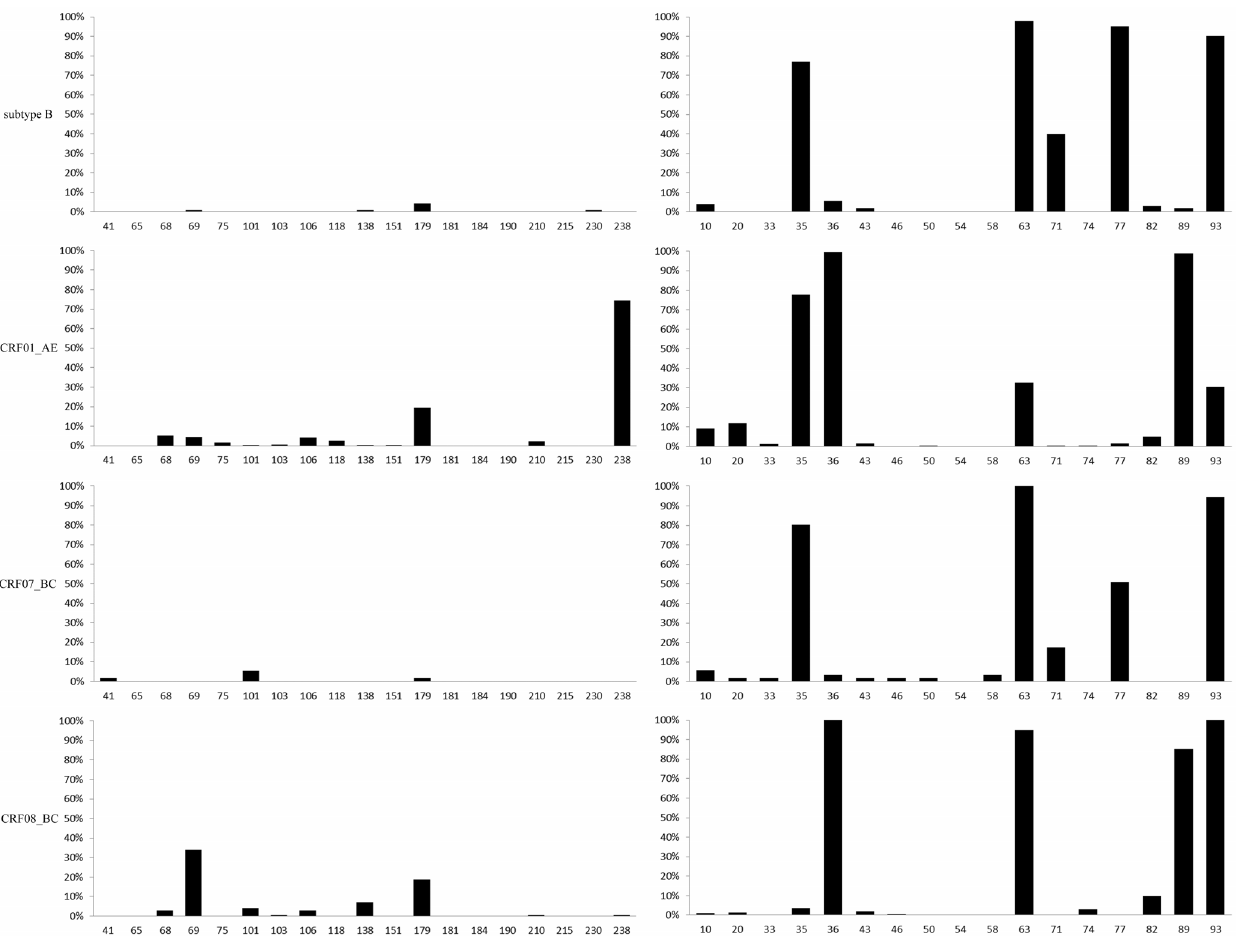
Figure 2. Subtype-specific drug resistance mutation sites genetic background analysis. Note: left part based on RT region and right part based on protease region, horizontal numbers indicate drug resistance mutation sites with significant difference among subtypes(chi-square or fisher’s exact test, p , 0.05), vertical percentage indicate the proportion of mutated amino acids differ from the subtype B consensus sequence.